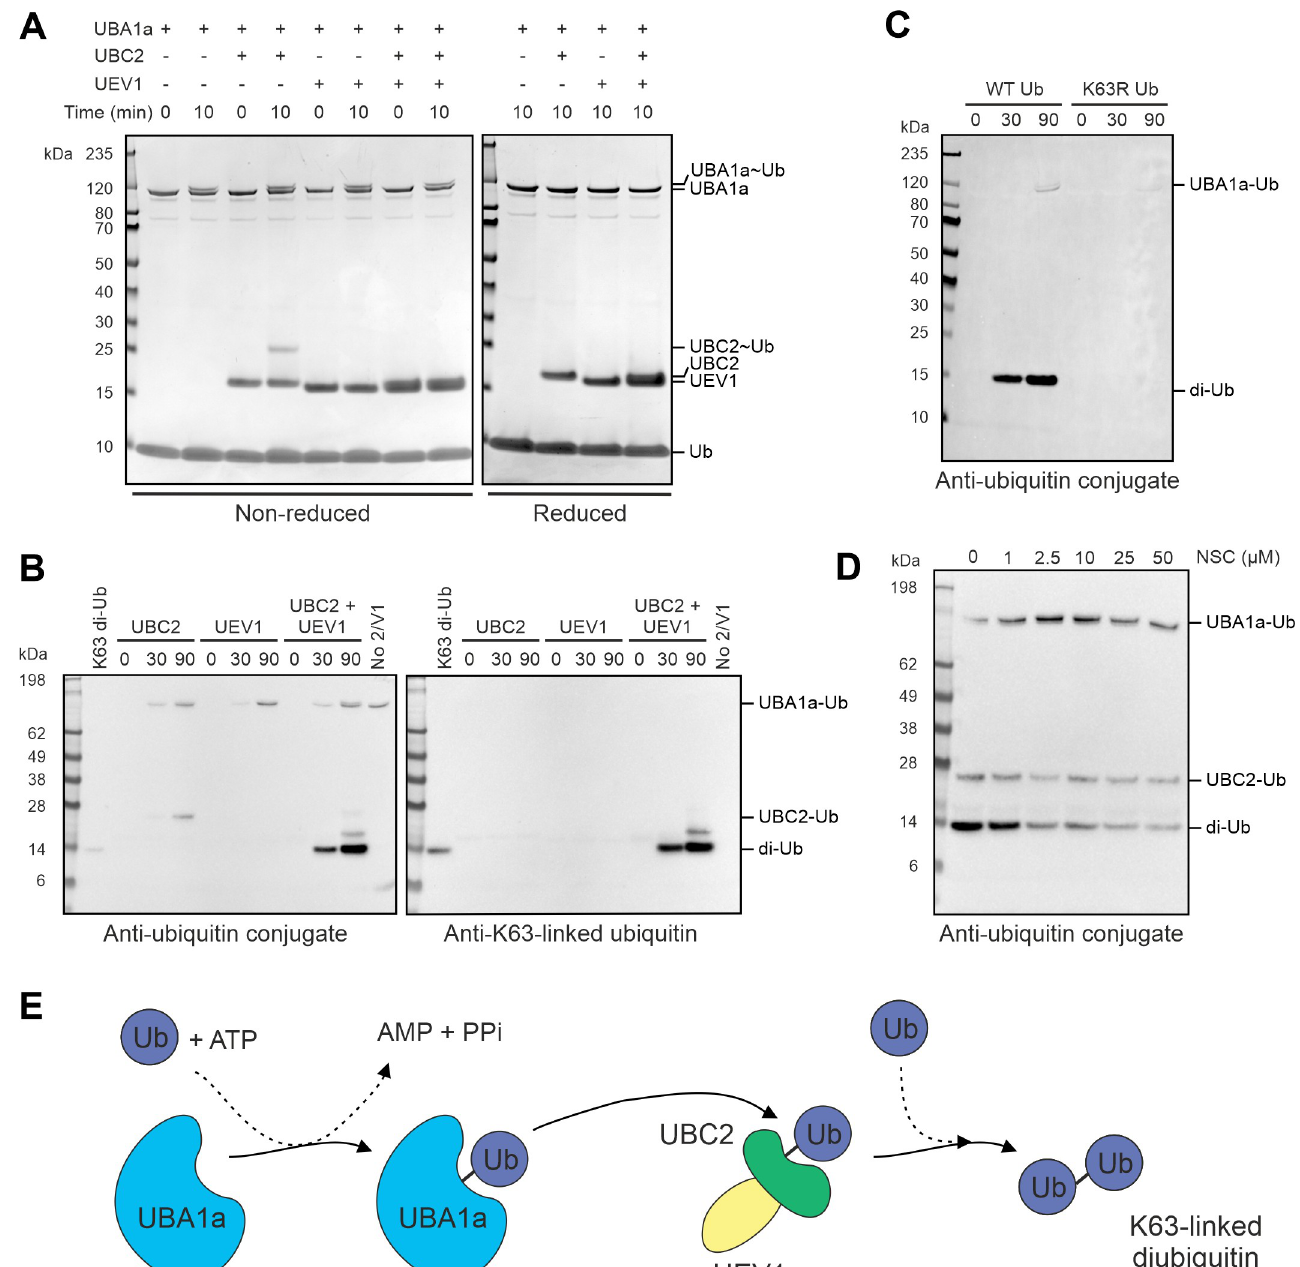
Fig 5. UBA1a and UBC2 cooperate in ubiquitin transfer in vitro. A Thioester assay demonstrating the ability of UBA1a and UBC2 to form thioester bonds with ubiquitin. UBA1a, ubiquitin and ATP were incubated with UBC2 and UEV1 as indicated in ubiquitination assay buffer for up to 10 min at room temperature. Samples were treated with either reducing or non-reducing sample buffer and visualised by SDS-PAGE with InstantBlue stain. B Di-ubiquitin formation assay. UBA1a, ubiquitin and ATP were incubated with UBC2 and UEV1 as indicated in ubiquitination assay buffer for up to 90 min at 37˚C. Reactions were then treated with reducing sample buffer and visualised by immunoblotting with either ubiquitin conjugate or K63-linked ubiquitin antibodies. C Di- ubiquitin formation assay performed as for B but with wild-type ubiquitin substituted for K63R ubiquitin where shown. D UBC2 and UEV1 were pre-incubated with UBE2N inhibitor NSC697923 as indicated for 15 min prior to setting up a di-ubiquitin formation assay as in B . For C and D , samples were treated with reducing sample buffer prior to SDS-PAGE and immunoblotting with ubiquitin conjugate antibody. Data shown in A-D are representative. No 2/V1, no UBC2 or UEV1. E Schematic summarising the findings of A-D . UBA1a activates ubiquitin in an ATP-dependent manner, allowing ubiquitin to bind to the active site of UBA1a via a thioester linkage. Ubiquitin is then transferred to UBC2 (green) which, when present in complex with UEV1 (yellow), can generate free K63-linked ubiquitin